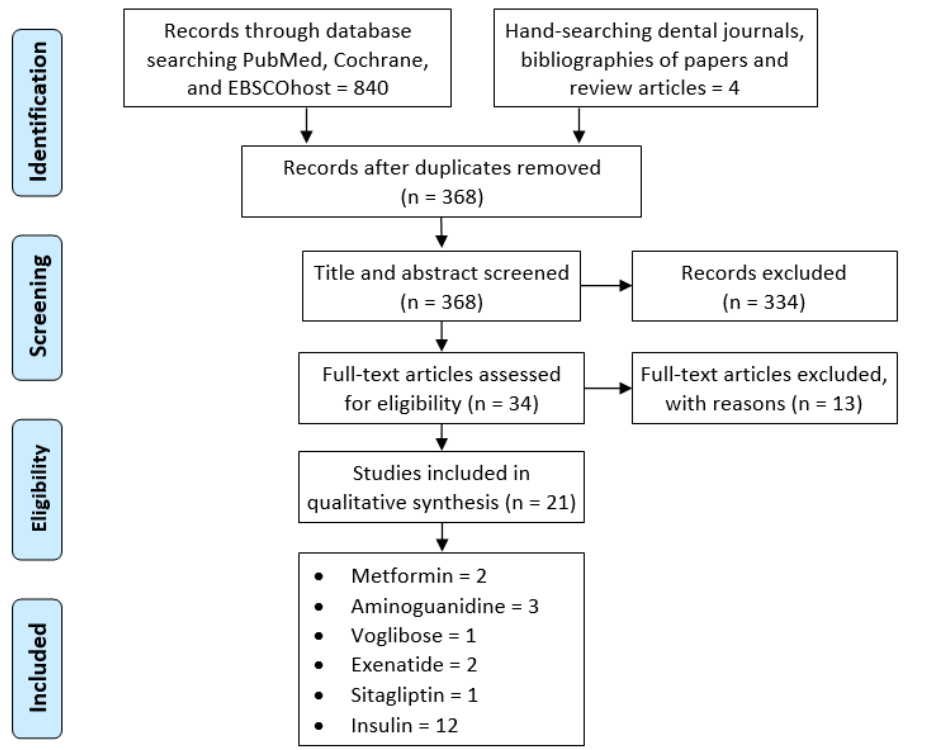
Figure 1. Flowchart of review process according to the Preferred Reporting Items for Systematic Reviews and Meta-Analyses extension for Scoping Reviews (PRISMA-ScR) guidelines.